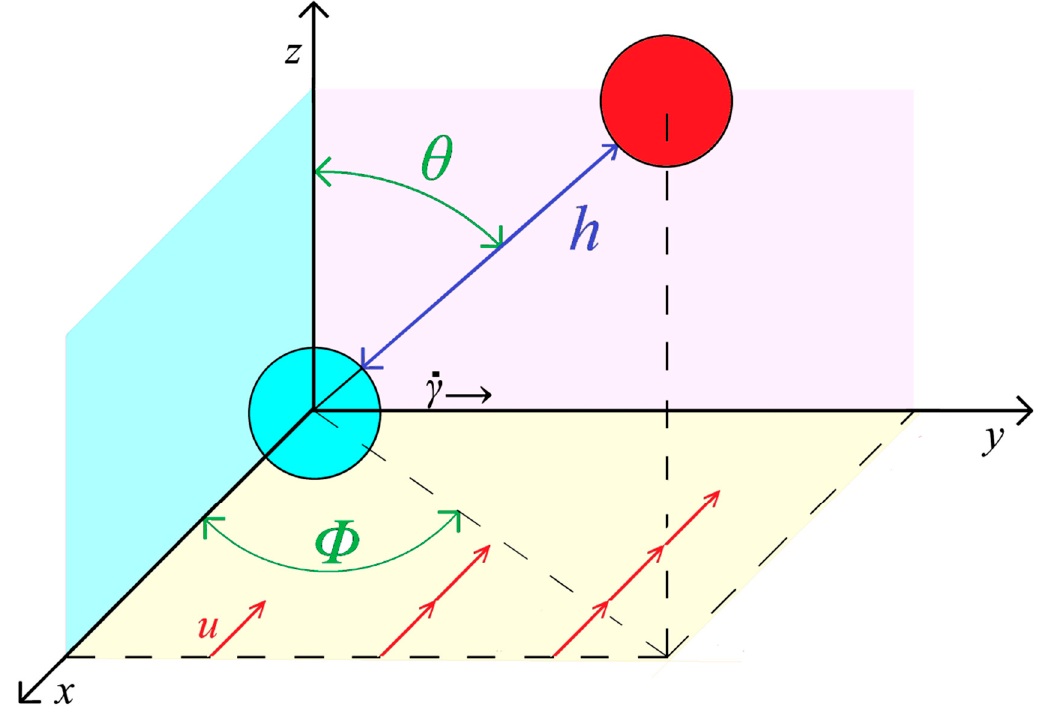
Figure 4. System geometry and parameters for shear-flow-induced coalescence described here. 327